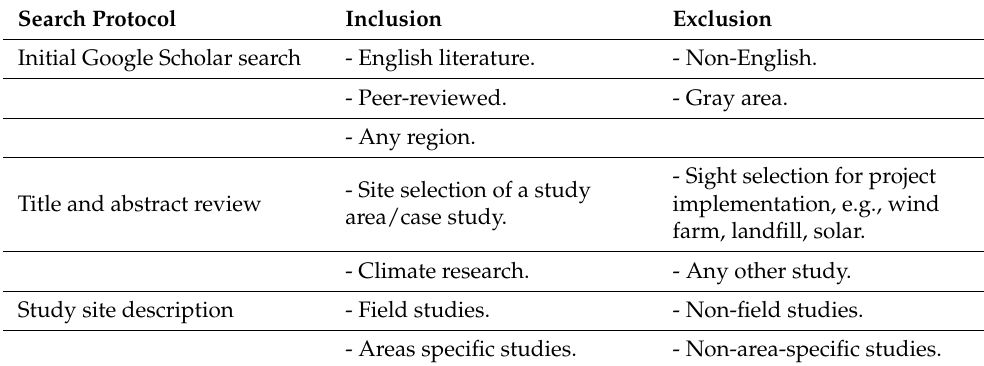
Table 1. Literature selection criteria to determine factors that contribute to study site